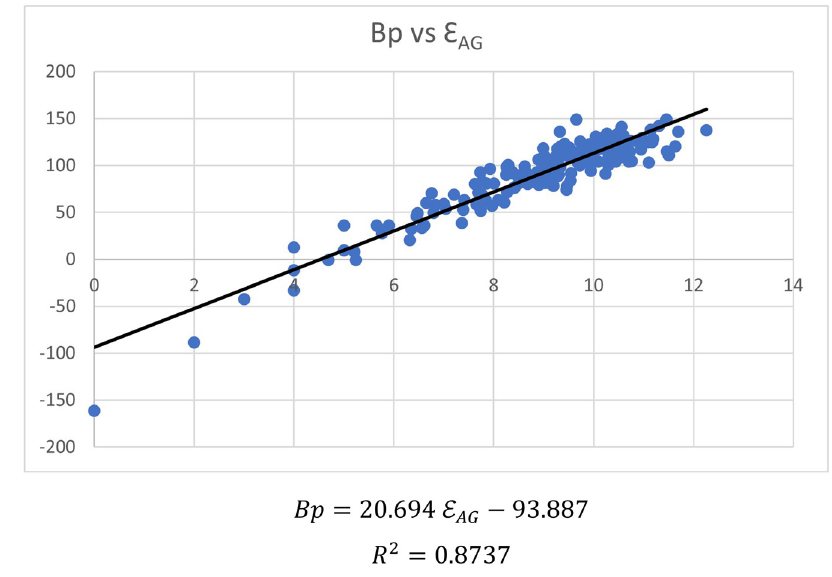
Figure 3: Linear regression Bp versus . AG